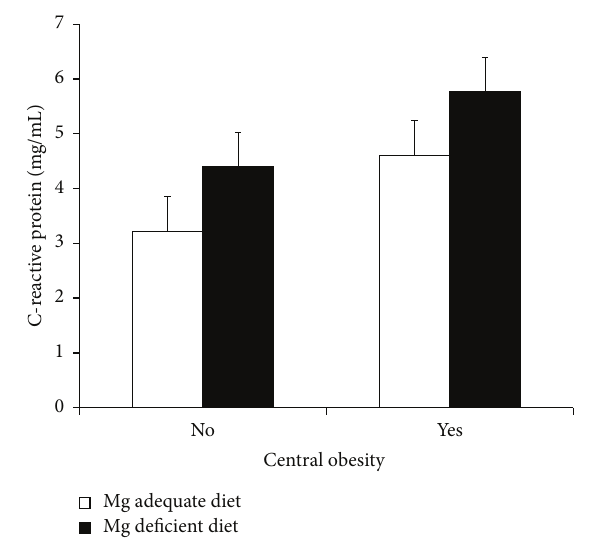
Figure 1: C-reactive protein stratified by central obesity and magnesium deficient diets. Children with central obesity presented higher C-reactive protein than normal waist circumference children ( 𝑃 = 0.019 ). Likewise, children who consumed a magnesium- deficientdietexhibitedhigherC-reactiveproteinconcentrationthan children with a normal diet ( 𝑃 = 0.028 ). No interaction between central obesity and deficient diet was